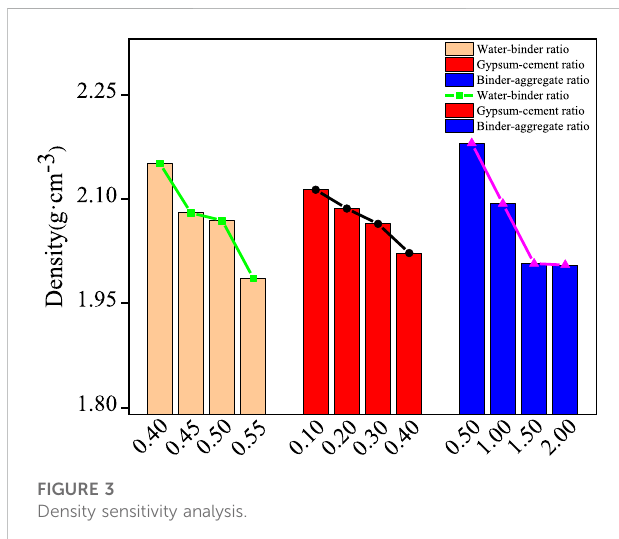
FIGURE 3 Density sensitivity analysis.